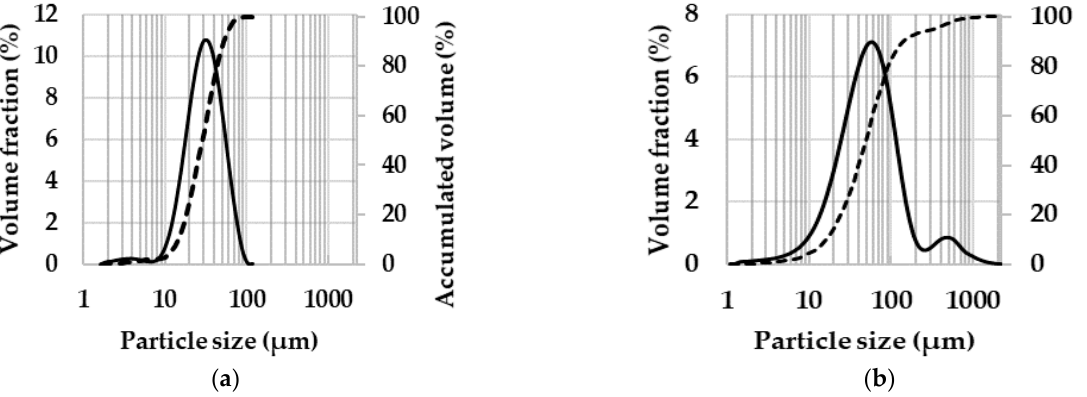
Figure 3. Particle size distribution: ( a ) AA7075 powder; ( b ) AA7075-M powder. The solid lines represent the volume fraction and the dashed lines represent the cumulative volume.